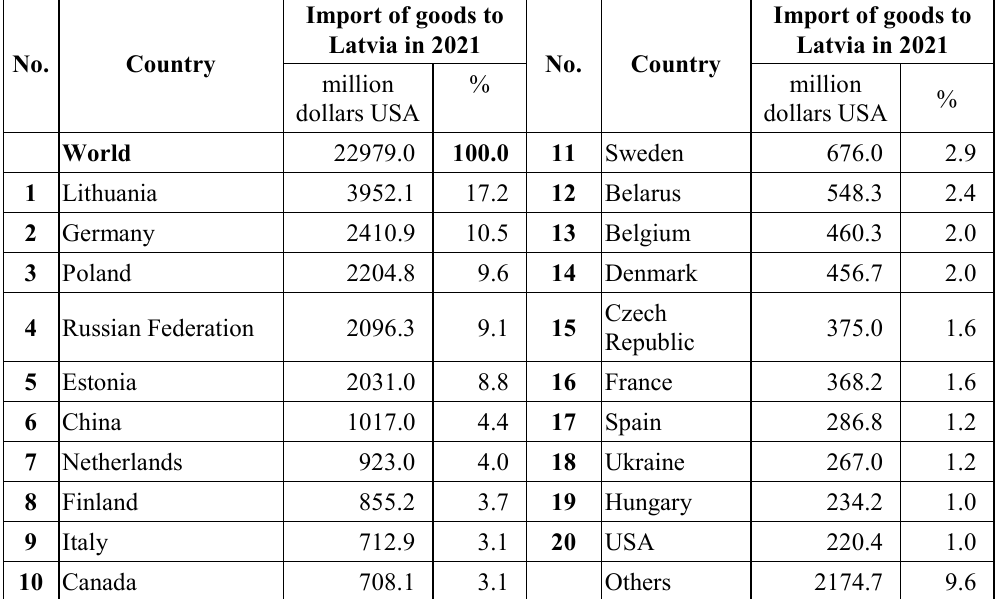
Table 2. Top 20 Countries-Importers of Goods to Latvia in 2021 (calculated